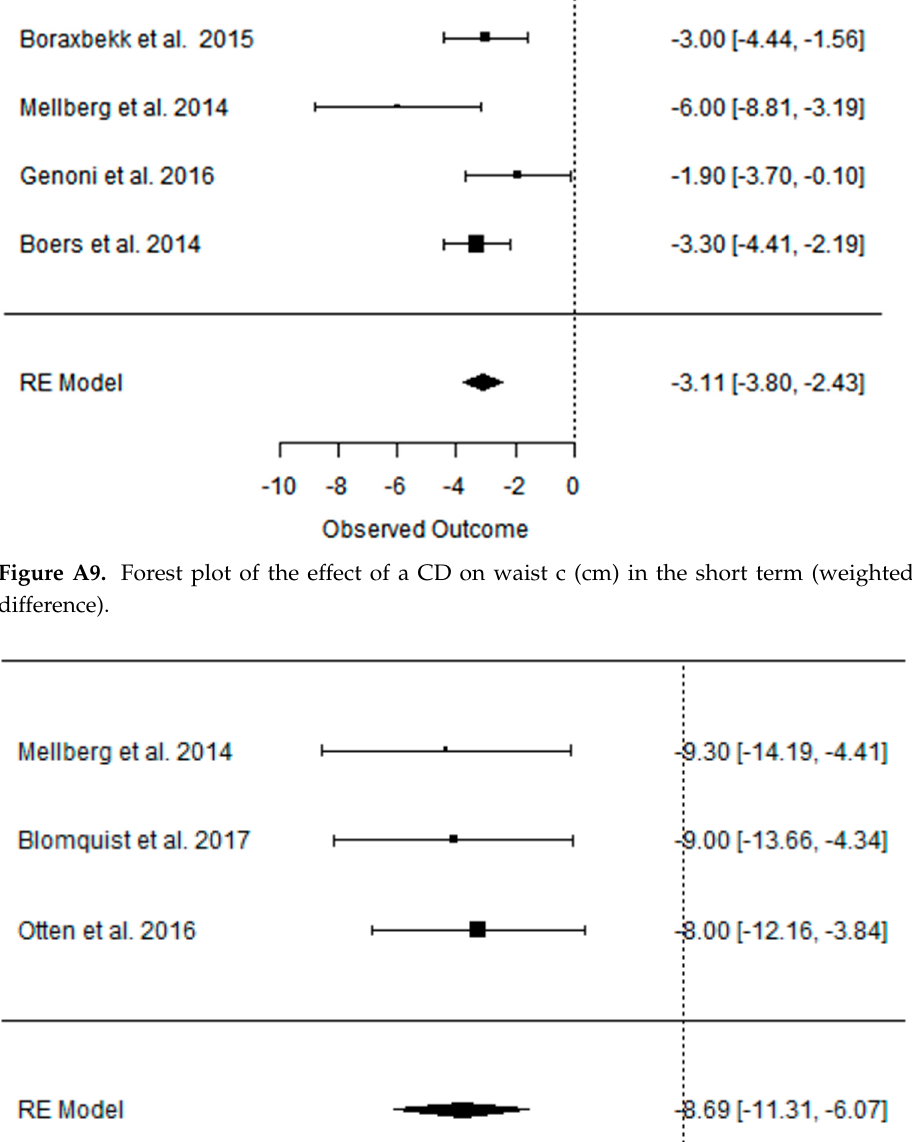
Figure A8. Forest plot of the effect of PD on waist circumference (cm) in the short term (weighted mean difference).